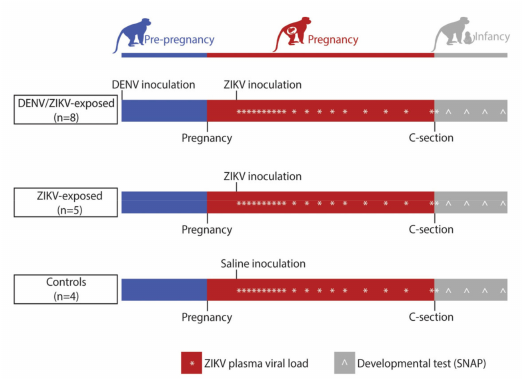
Figure 1. Experimental timeline schema. Female macaques (n = 8) were inoculated with DENV 1–2 months prior to breeding. Around gestational day 45, dams were either inoculated with ZIKV or saline. Blood was drawn daily to measure ZIKV plasma viral loads (*) for 10 days, then twice weekly until viremia cleared, then weekly until delivery by Cesarean section (C-section). Infants had blood drawn for a ZIKV plasma viral load within the first week of life and participated in weekly neurodevelopmental exams (Schneider Neonatal Assessment Protocol; SNAP) weekly (ˆ) for the first month of life. Precise gestational days at inoculation and C-section are noted in Table 1, and average infant ages at developmental testing are noted in Supplementary Table